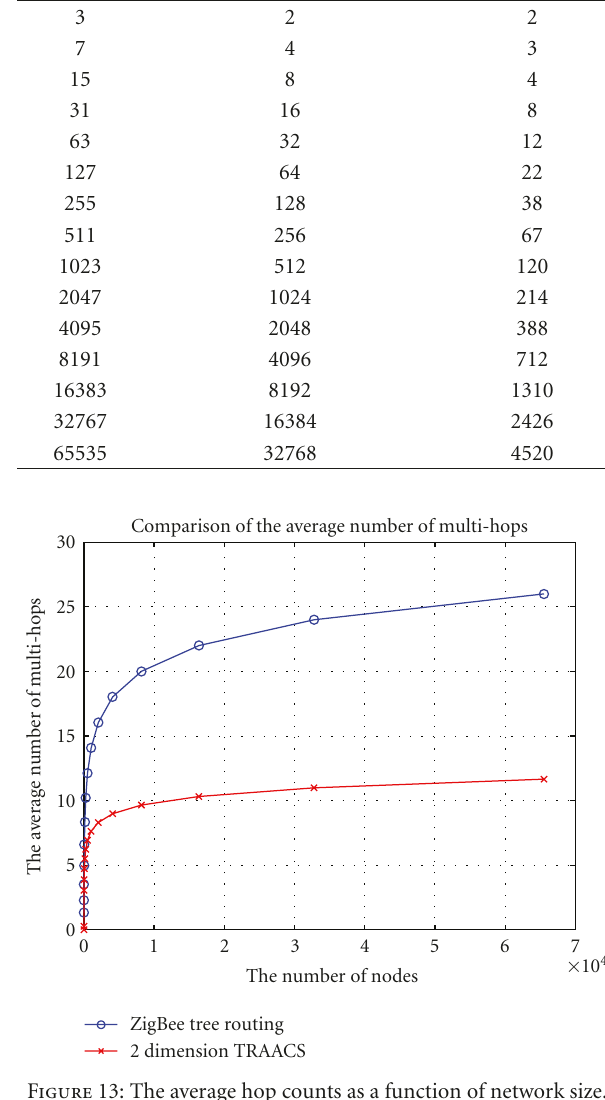
Figure 13: The average hop counts as a function of network